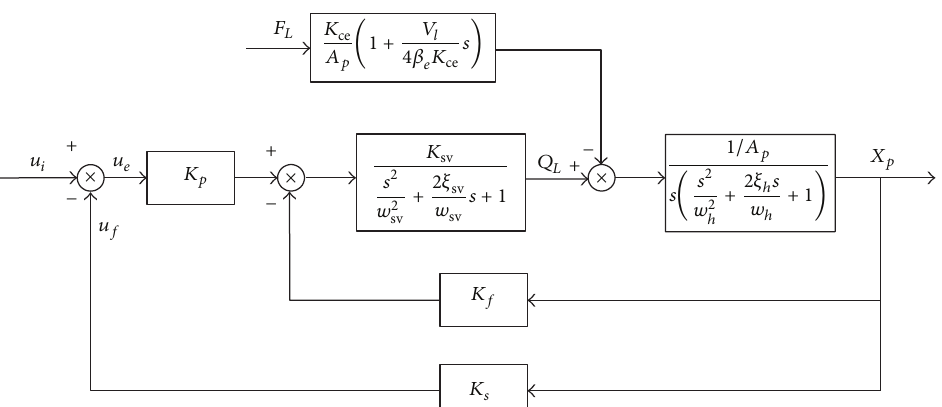
Figure 3: Block scheme of the hydraulic servo system.